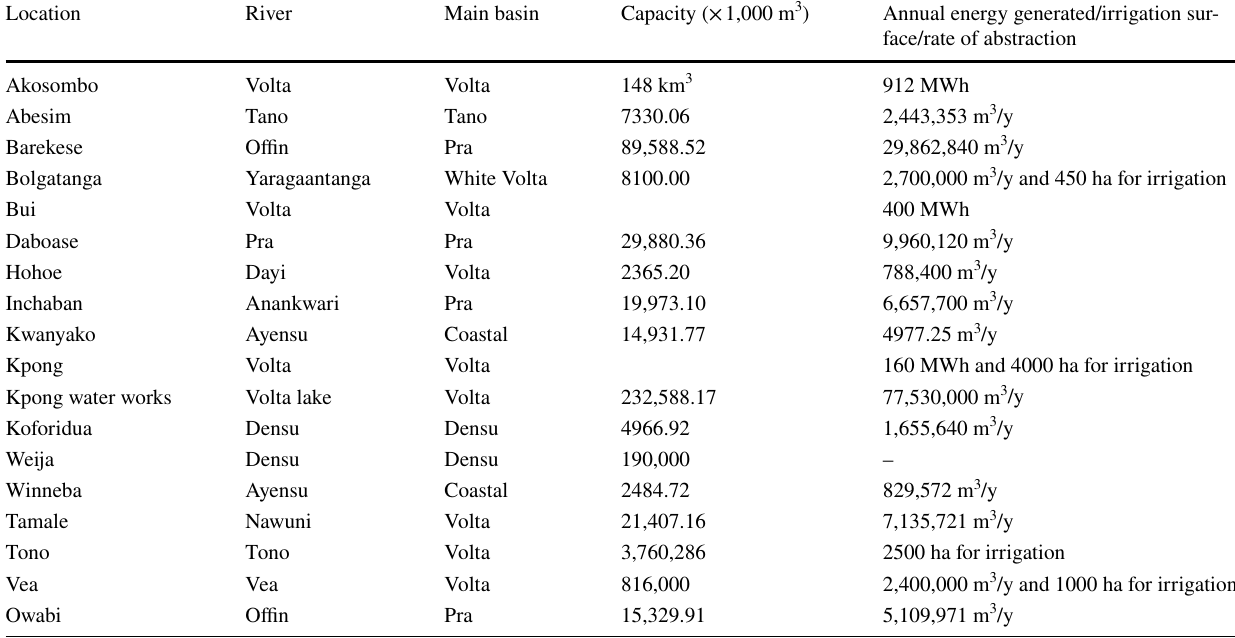
Table 1 Characteristics of some major reservoirs or impoundments in Ghana and their estimated annual generation rate or irrigation surface or abstraction rate. Source : Ministry of Water Resources, Works and Housing (1998) and WRC (2005)